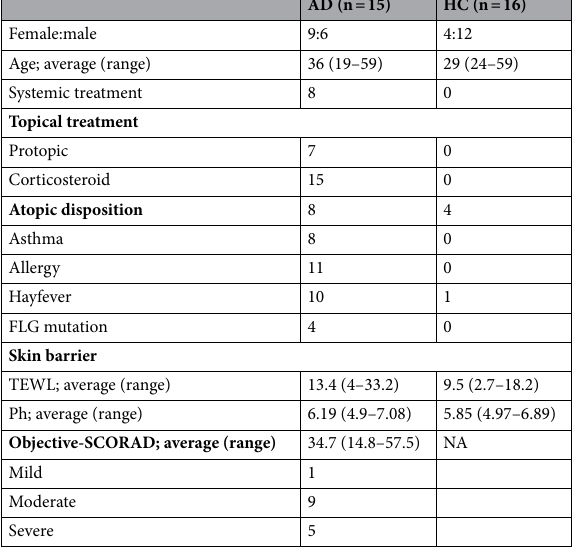
Table 1. Demographic